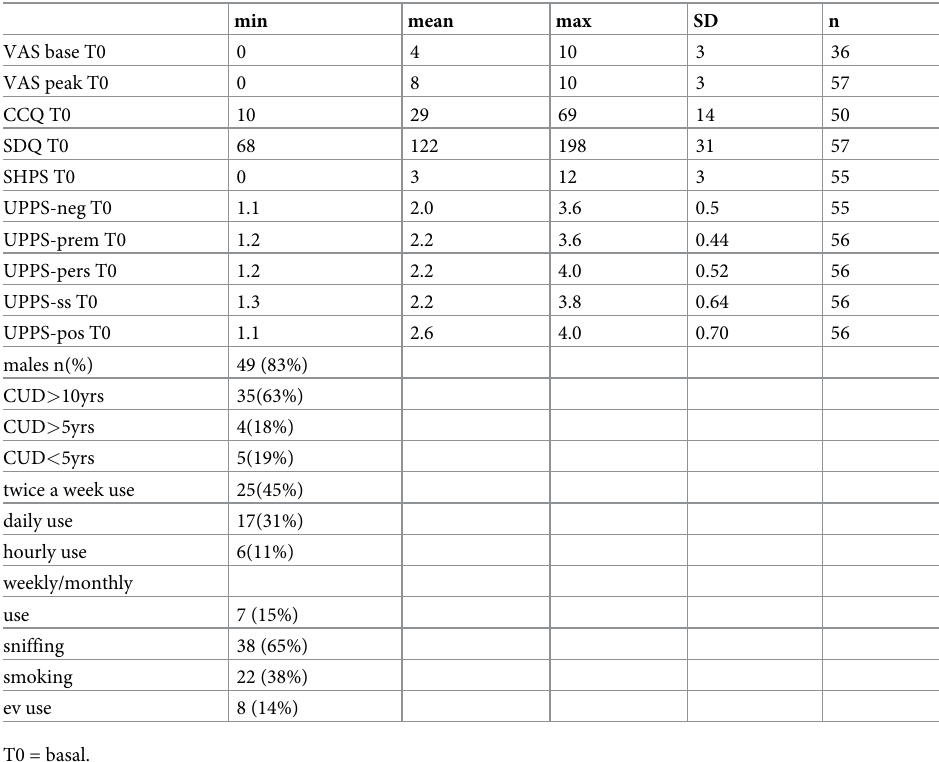
Table 1. Patient’s data at